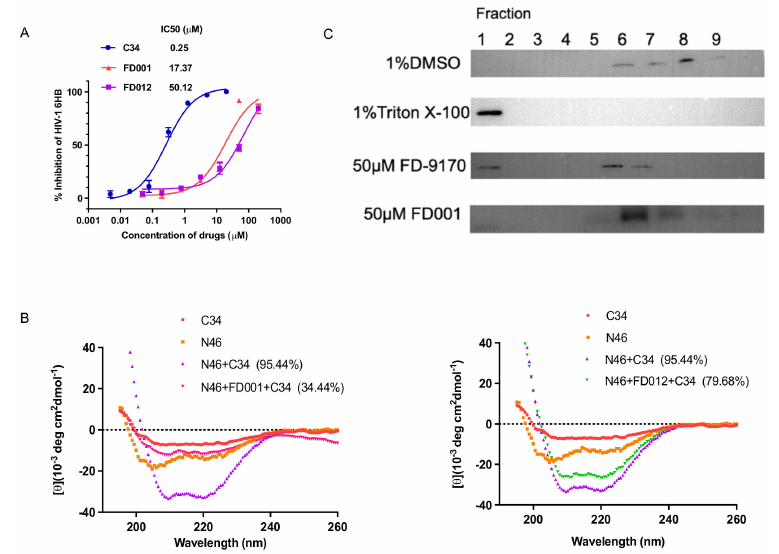
Figure 4. FD-compounds inhibited HIV-1 6-HB formation and did not disrupt the integrity of the viral membrane. FD-compounds inhibited HIV-1 6-HB formation between N46 and C34 peptides measured by ELISA ( A ) and CD spectroscopy ( B ); compound FD001 did not disrupt the integrity of the viral membrane ( C ).